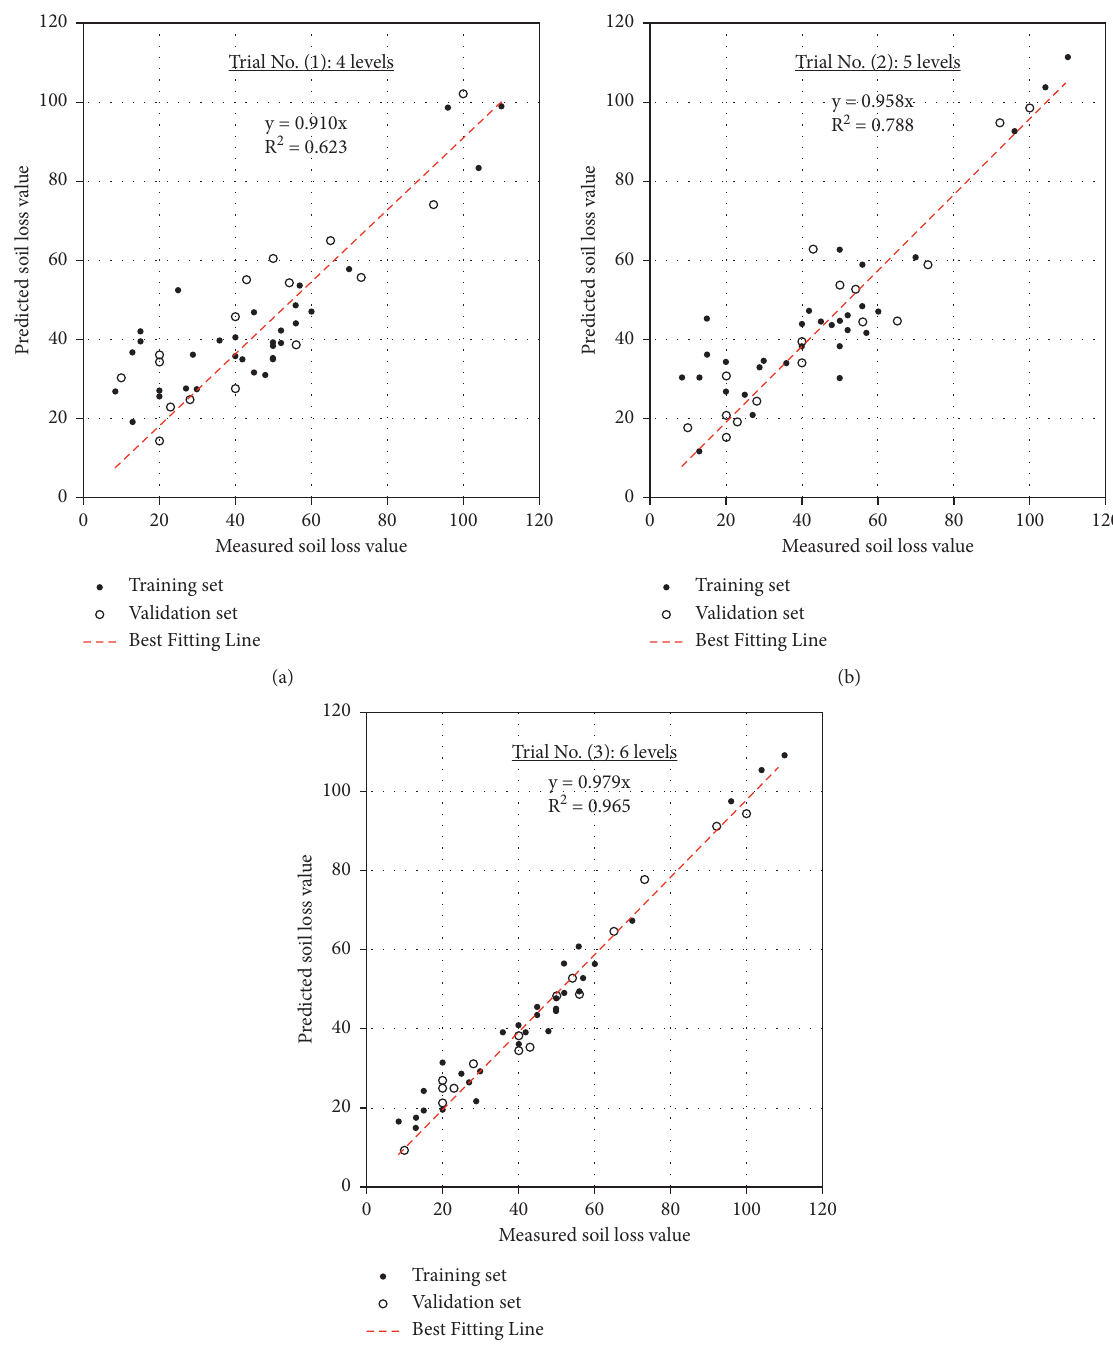
Figure 12: Relation between predicted and measured soil loss values using the different developed